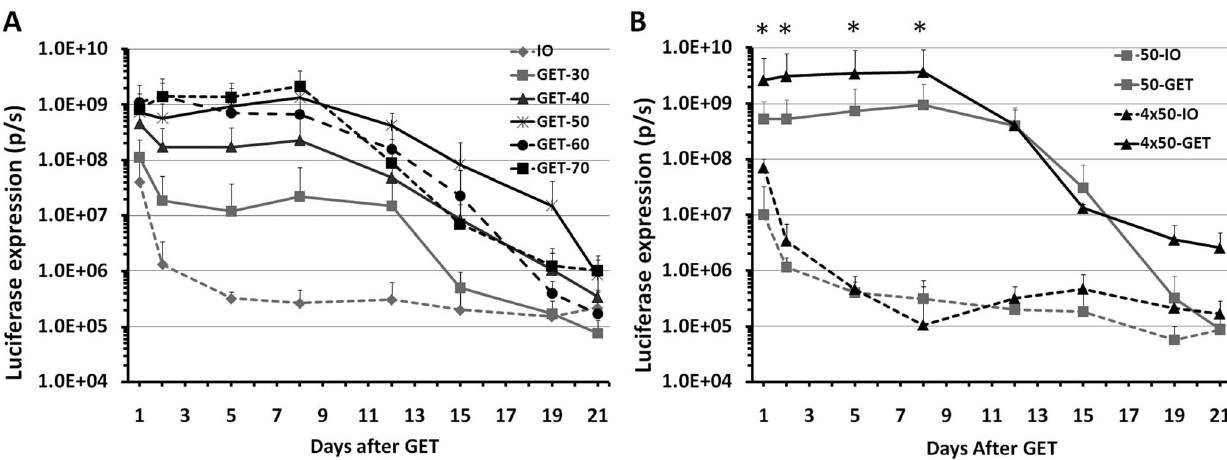
Figure 1. Kinetic of gene expression in HLGP skin after intradermal DNA injection and non-invasive GET. A , Time course of luciferase expression in HLGP skin after delivery by different electric fields at day 0. 50 m L DNA and 1 pulse delivery for all delivery groups, IO: no pulse delivery; GET: applied voltage of 30, 40, 50, 60 or 70. *: p , 0.05 for GET-50, GET-60 or GET-70 vs IO. B , Time course of luciferase expression in HLGP skin after delivery to different sizes of skin. Delivery groups, 50-IO: 50 m L DNA without pulse delivery; 50-GET: 50 m L DNA with 1 pulse delivery on the injection site; 50 m Lx4-IO: 4 injections with 50 m L DNA without pulse delivery; 50 m Lx4-GET: 4 injections with 50 m L DNA and each pulse delivery on the injection site. Bars represent mean 6 SD. 4–6 sites were analyzed for each delivery parameter, p/s = photons/second. * p , 0.05 for 4 6 50-GET vs 50- GET and 4 6 50-GET vs 4 6 50-IO. (Fig 1B, p , 0.05 for 4 GET vs 1 GET). Eight days after electrogene delivery, gene expression in both groups gradually decreased. However, at day 21 post-delivery, the gene expression in the group treated in the larger area maintained 1 log higher than the control group without GET. For the group receiving the single GET application, gene expression was similar to the respective control group.